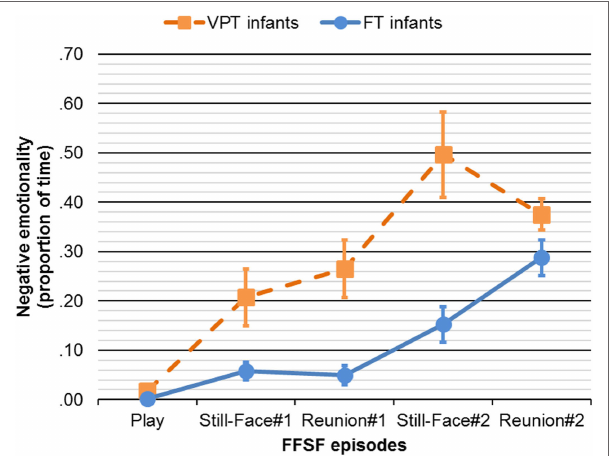
FigUre 2 | Negative emotionality through the FFSF episodes in VPT and FT infants. Continuous line represents FT infants. Dotted line represents VPT infants. FFSF, Face-to-Face Still-Face; VPT, very preterm; FT, full-term. Bars represent SEs.